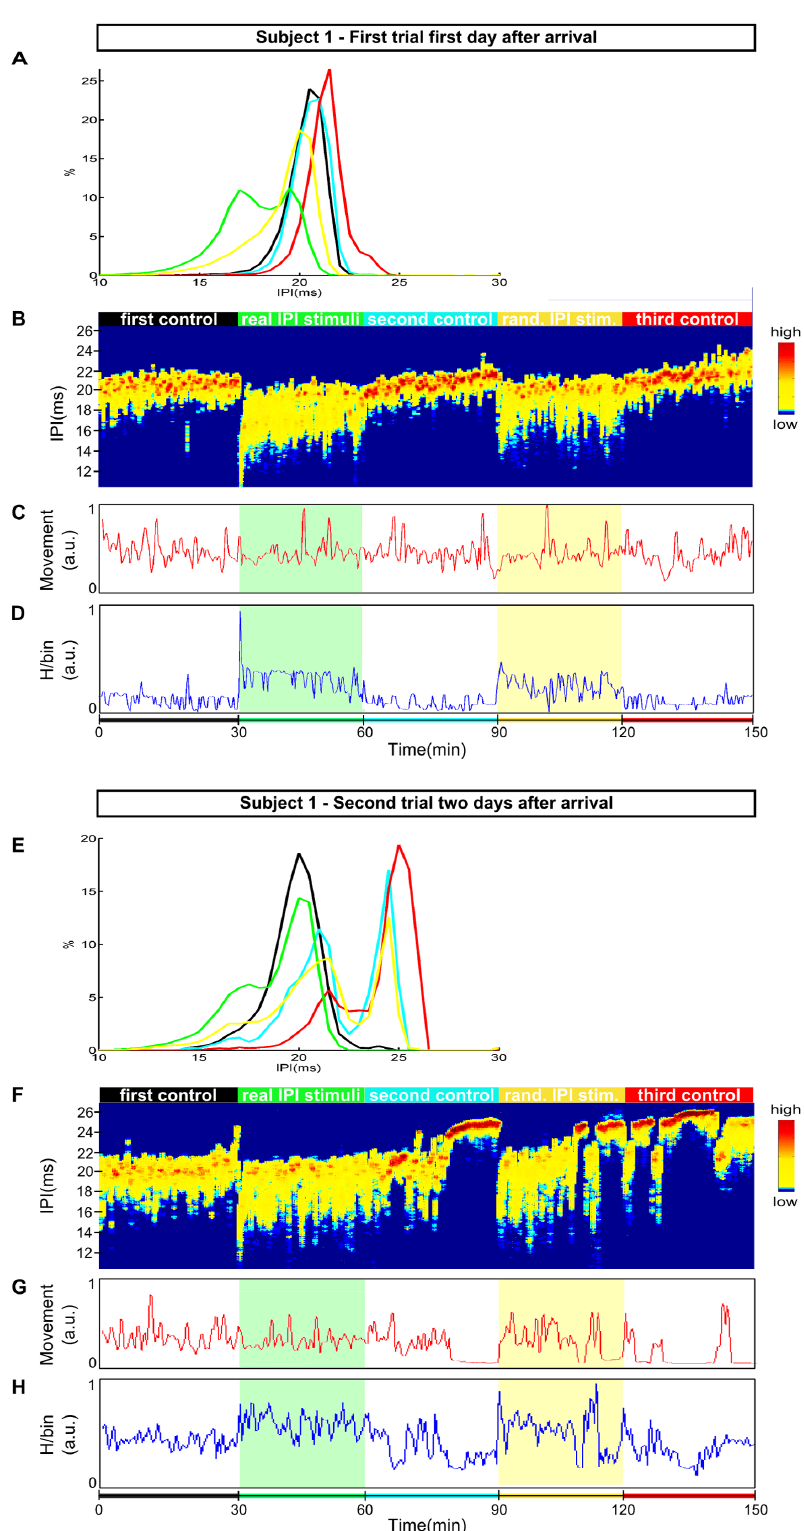
Figure 6. Experiments with stimulation. The protocol was a sequence of 5 sessions (30 min each) as follows: first control recording (without stimulation)(black), stimulation with a real distribution of IPIs (green), second control (blue), stimulation with random distribution of IPIs (yellow), and a final control (red). A- Histograms of the response IPIs for each session: first, second and third controls in black, blue and red respectively. Response to real stimuli in green and to random one in yellow. In the first 30 min, fish discharged mostly 20.5 ms IPIs. In response to real IPI stimuli, the IPI distribution was bimodal with 2 equally probable values: 17 ms and 19.5 ms. In the second control session the IPI distribution changed presenting a